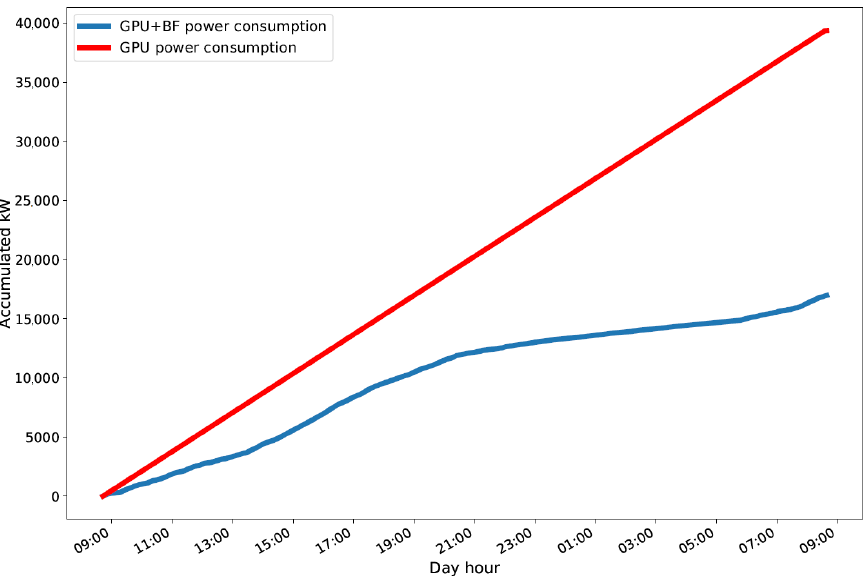
Figure 6. Energy consumption accumulation throughout the